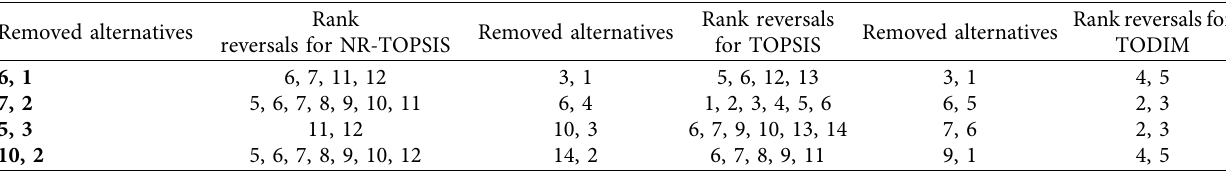
Table 16: Comparison of rank reversal results of NR-TOPSIS, TOPSIS, and TODIM when two alternatives are removed from the original rank list of batsmen.